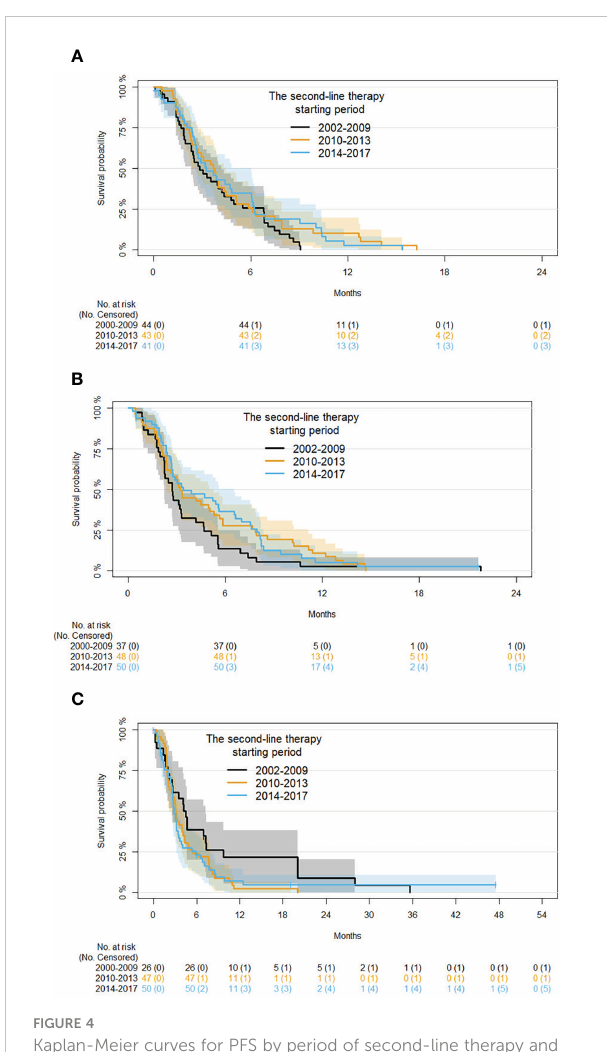
FIGURE 4 Kaplan-Meier curves for PFS by period of second-line therapy and age (subgroup analysis on patients with age ≤ 60, 61 to 70, and ≥ 71 years are shown in panels (A-C) ,